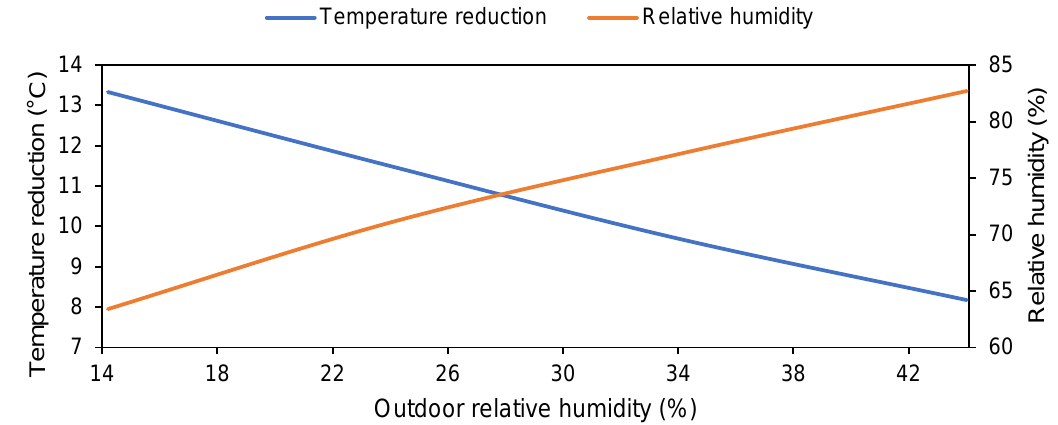
Figure 13. The influence of varying ambient relative humidity on the temperature reduction and indoor relative humidity (outdoor T = 40 °C, U HWC = 4.4 m/s at windcatcher roof height).